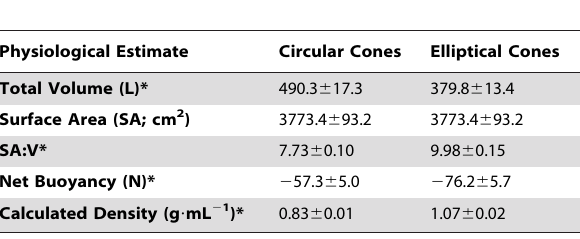
accurate absolute and percent TBL HTO used middle dorsal or sternum lateral blubber depth measures, respectively, instead of the traditional single axillary blubber measurement [28].